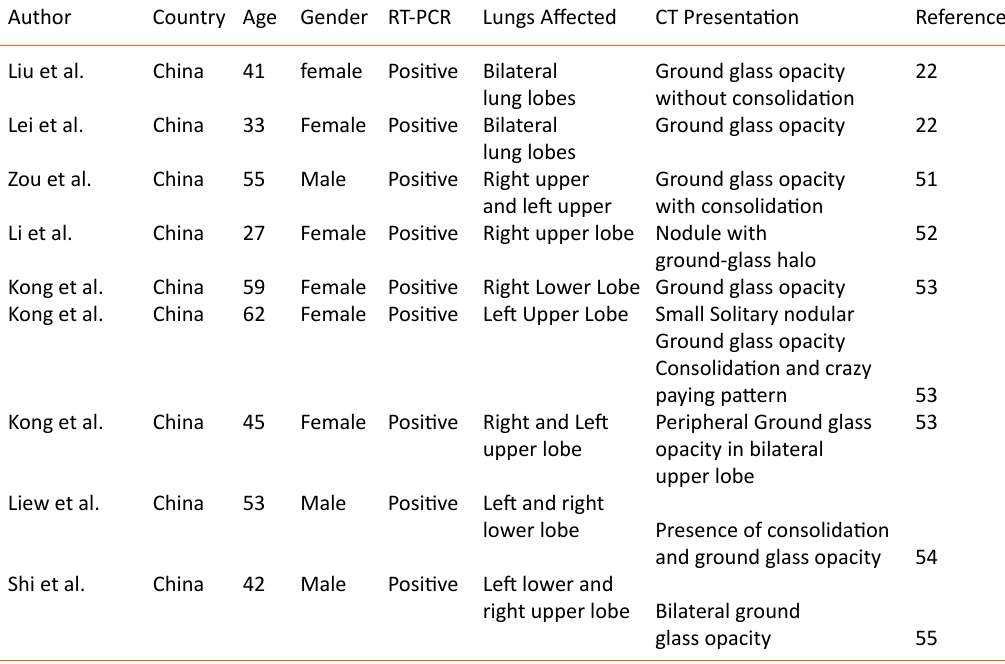
Table 4. Case reports and Case presentations reported from around the